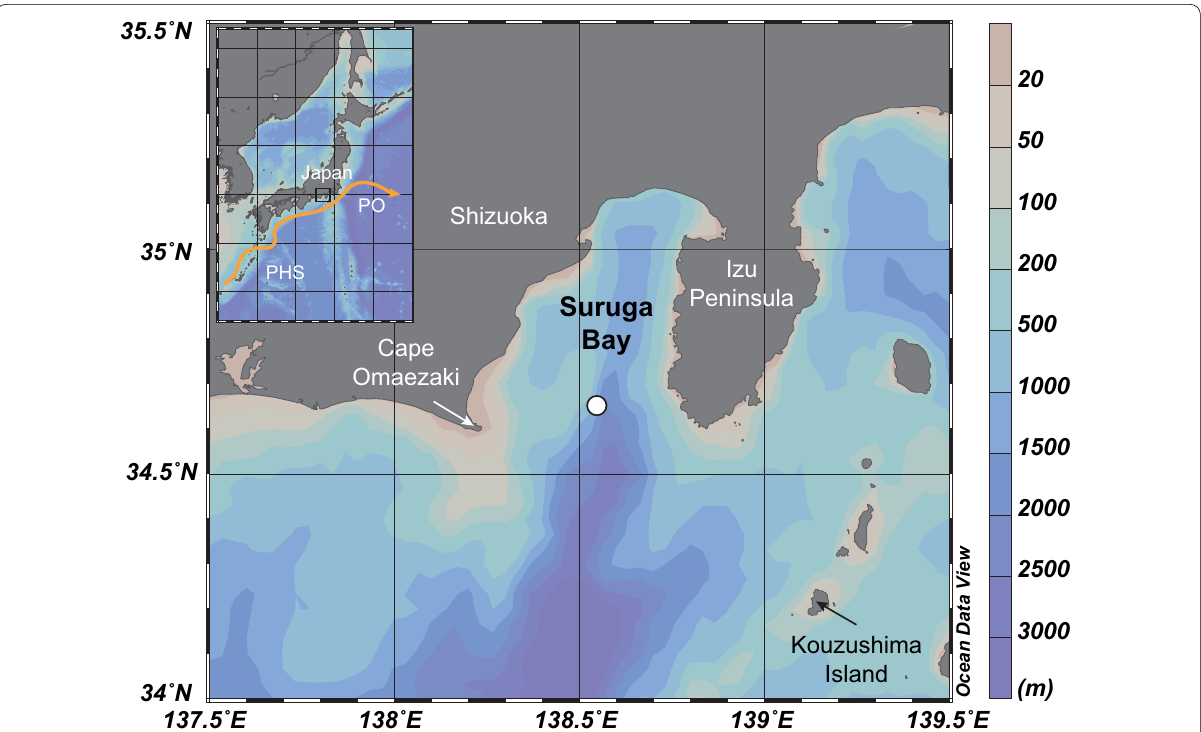
Fig. 1 Location of a plankton tow site (white circle) in Suruga Bay, Japan. Orange line in the insert map indicates the Kuroshio current at the time of sampling. PO Pacific Ocean, PHS Philippine